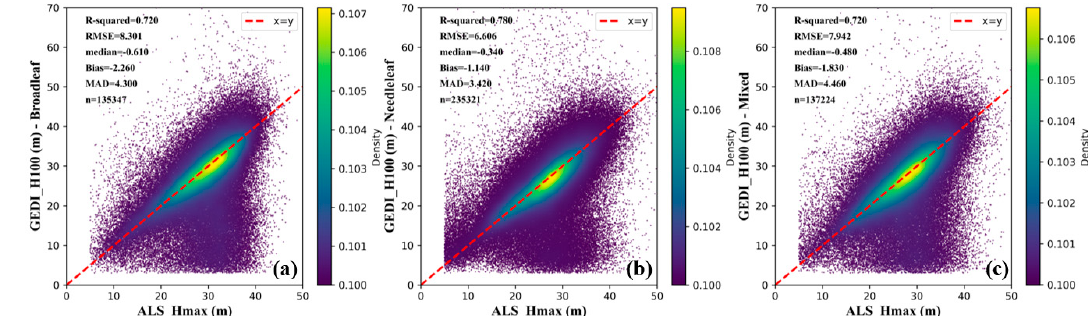
Figure 4. GEDI-H100 versus ALS-Hmax for algorithm group 2 in three forest types, including ( a ) broadleaf, ( b ) needleleaf, and ( c ) mixed.